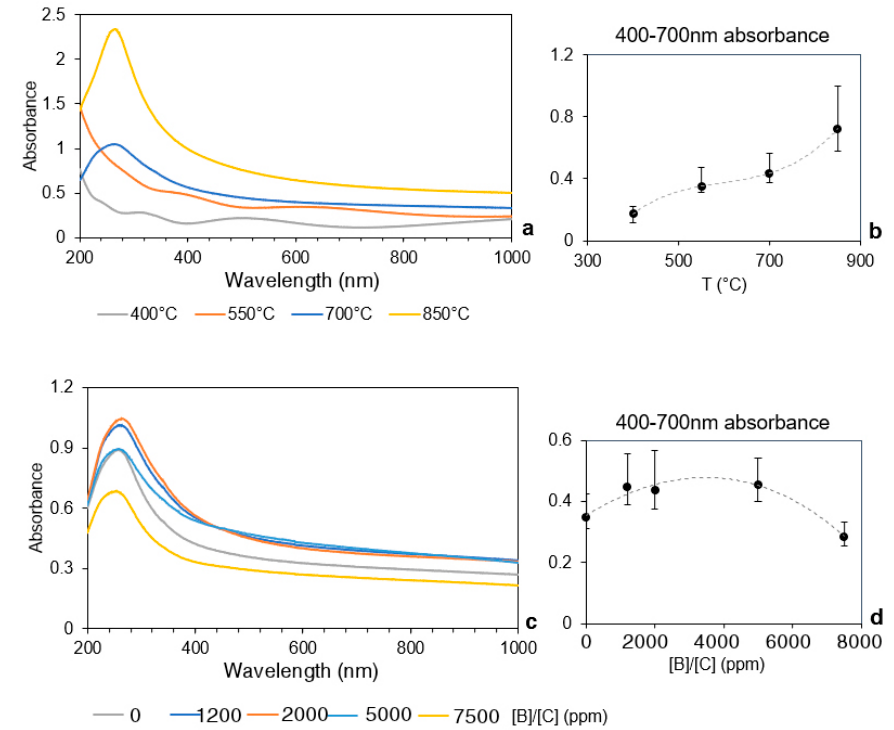
Figure 4. ( a ) UV-visible absorbance spectrum and ( b ) 400–700 nm average absorbance for B-CNW Figure 4. ( a ) UV ‐ visible absorbance spectrum and ( b ) 400–700 nm average absorbance for B ‐ CNW growth at 400 ◦ C, 550 ◦ C, 700 ◦ C, and 850 ◦ C at 2000 ppm [B]/[C] ratio; ( c ) UV-visible absorbance growth at 400 °C, 550 °C, 700 °C, and 850 °C at 2000 ppm [B]/[C] ratio; ( c ) UV ‐ visible absorbance spectrum and ( d ) 400–700 nm average absorbance for B-CNWs at 0, 1200, 2000, 5000, and 7500 ppm spectrum and ( d ) 400–700 nm average absorbance for B ‐ CNWs at 0, 1200, 2000, 5000, and 7500 ppm [B]/[C] at 700 ◦ C. [B]/[C] at 700 °C.